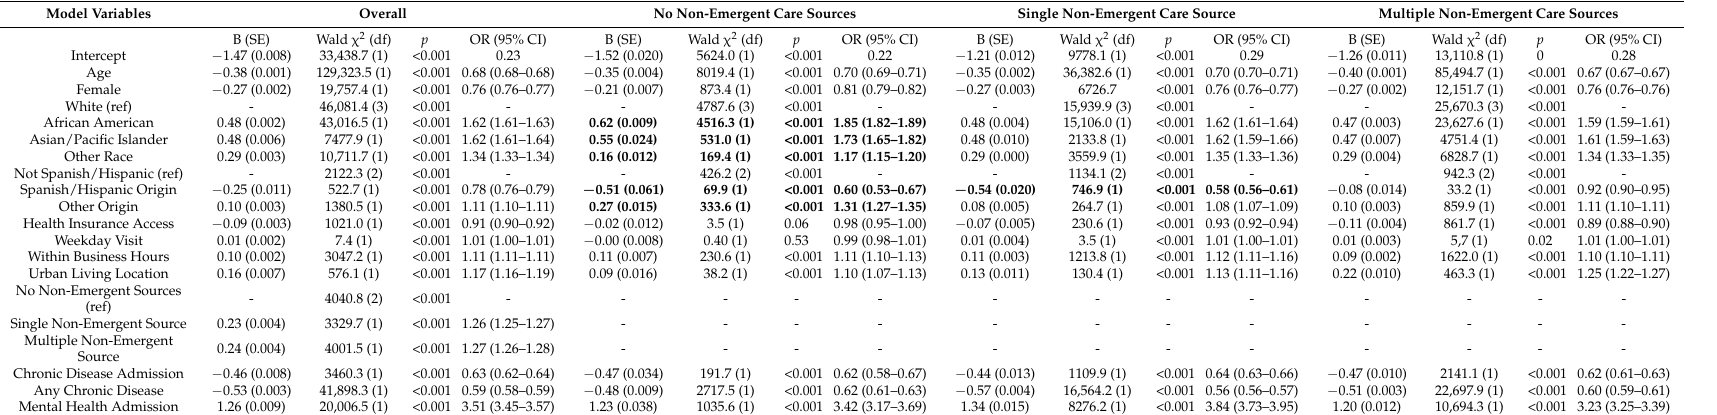
Table 3. Overall emergency department use compared to no non-emergent care sources emergency department use.